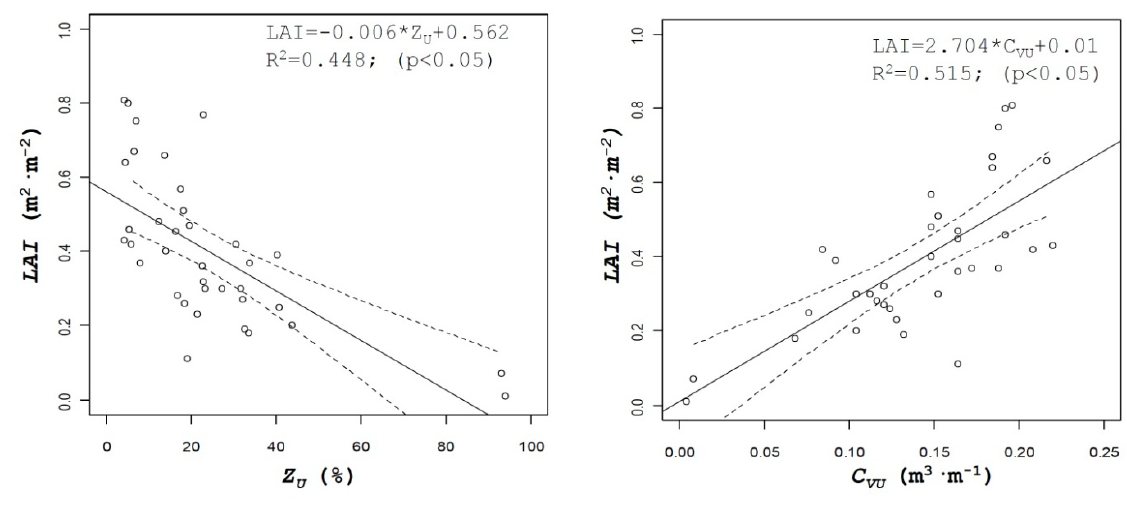
Figure 8. Correlation curves between measured leaf area index (LAI) and percent of zero values obtained with the two sensors (left). On the right side correlation between LAI and crop volume estimated with ultrasonic sensors and